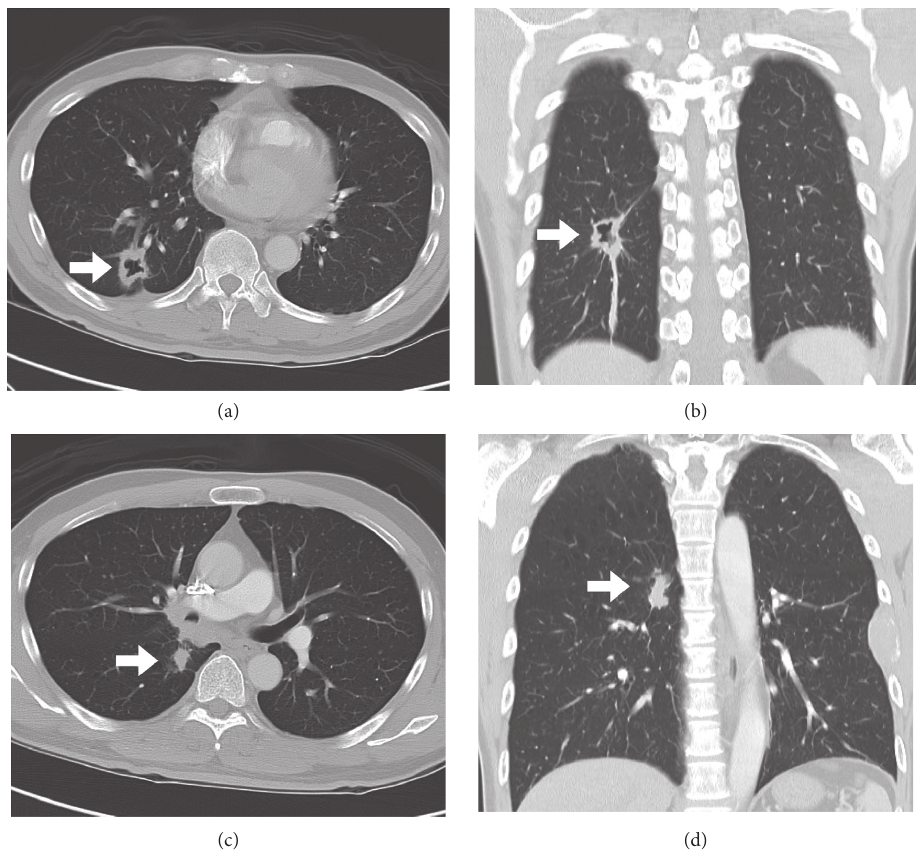
Figure 1: Low-dose lung CT demonstrated multiple right lung tumors (arrow).